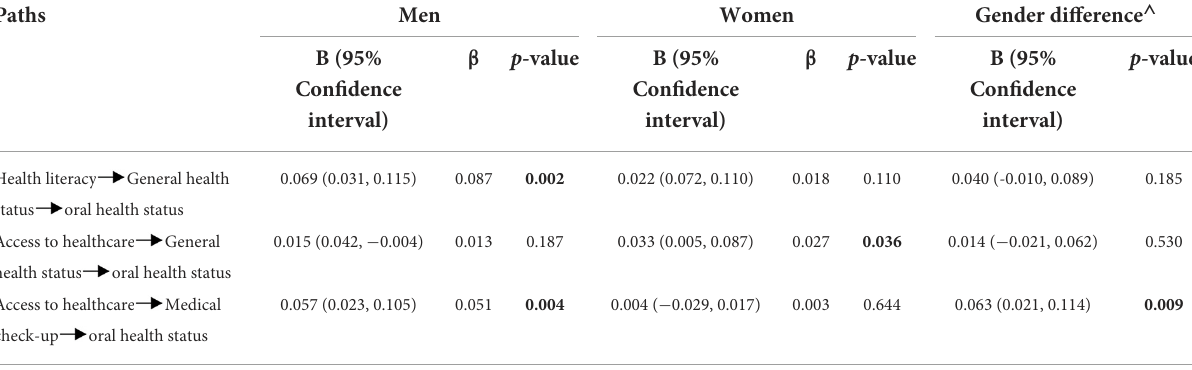
TABLE 6 Gender differences in the observed indirect effects of access to healthcare and oral health status of older persons.